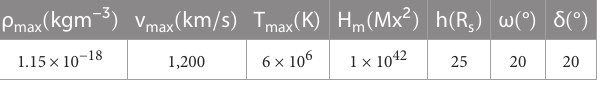
TABLE2 InitialparametersoftheCME(Liu et al.,2019).